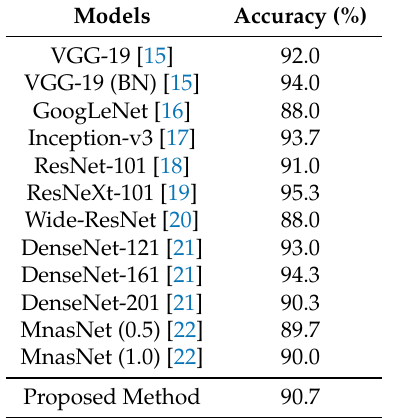
Table 4. Performance comparison with the existing CNNs on library/bedroom/kitchen